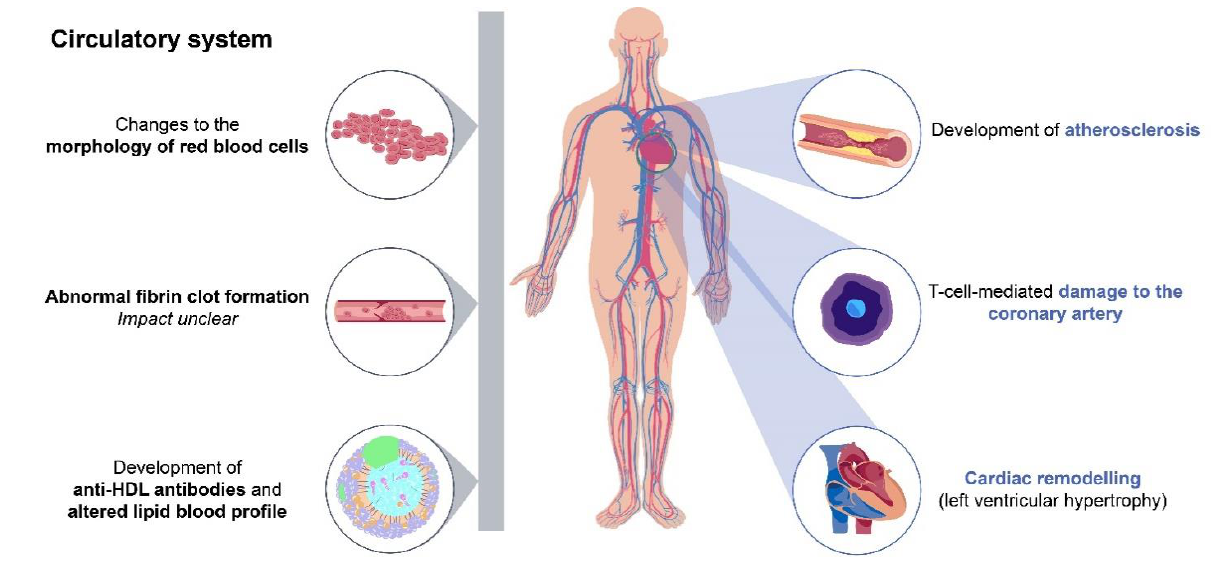
Figure 1. Chronic inflammation in rheumatoid arthritis as a risk factor for cardiovascular disease. The proinflammatory mechanisms underlying RA may contribute to the development of atherosclerosis [45–47], promotion of cardiac remodelling [48], alterations in lipid blood profiles [49] and changes to the morphology of red blood cells [50]. RA can be exacerbated by cytomegalovirus infection and is linked to coronary artery damage via cytotoxic T-cells [51]. The autoimmune mechanisms that drive RA have been linked to abnormal fibrin clot formation and increased CVD risk; however, the extent to which this is affected in RA remains unclear [52]. Grey bar indicates nonlocalised effects. Abbreviations: CVD, cardiovascular disease; HDL, high-density lipoprotein; RA, rheumatoid arthritis.